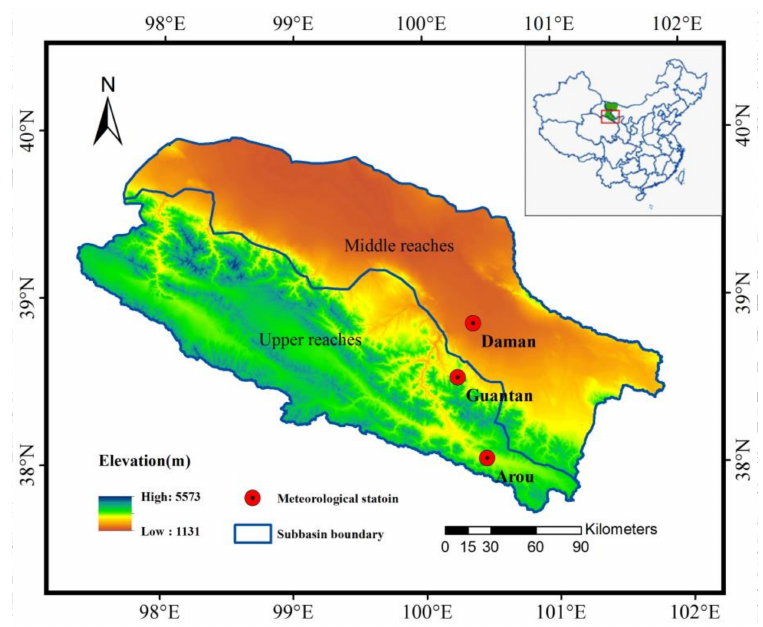
Figure 1. Locations of the three automatic weather stations (AWSs) in the Heihe River basin. The elevation map was produced using the ASTER GDEM product of METI and NASA (available